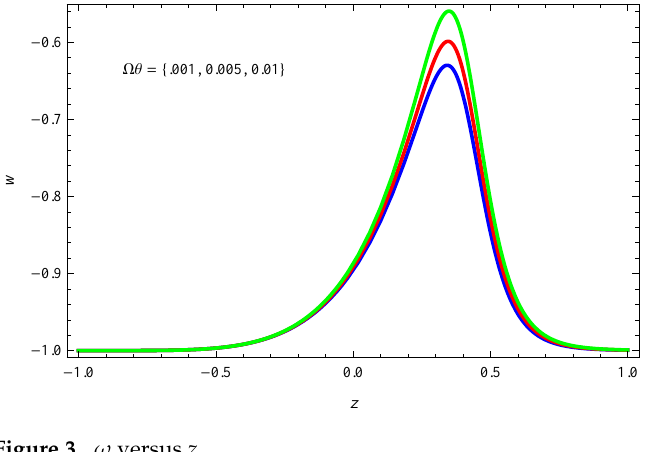
Figure 3. ω versus z